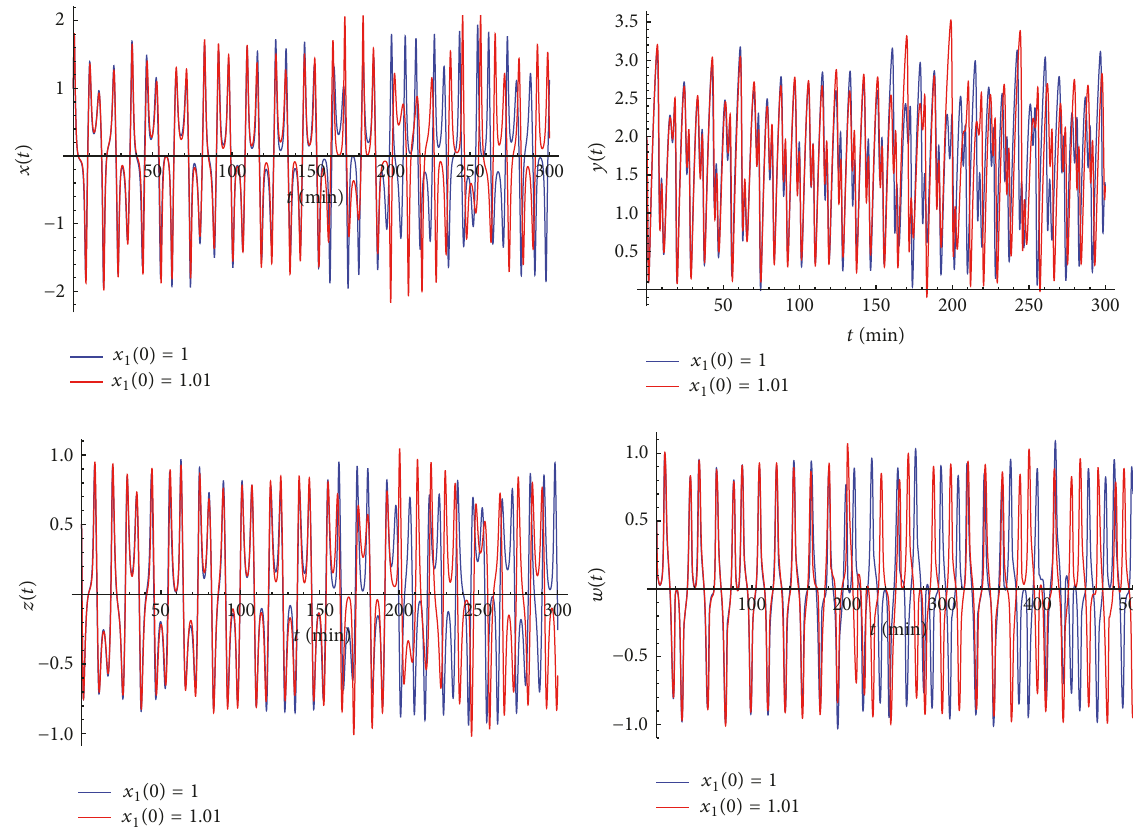
Figure 6: Time course of 𝑥 , 𝑦 , 𝑧 , 𝑤 of system (1) with similar initial